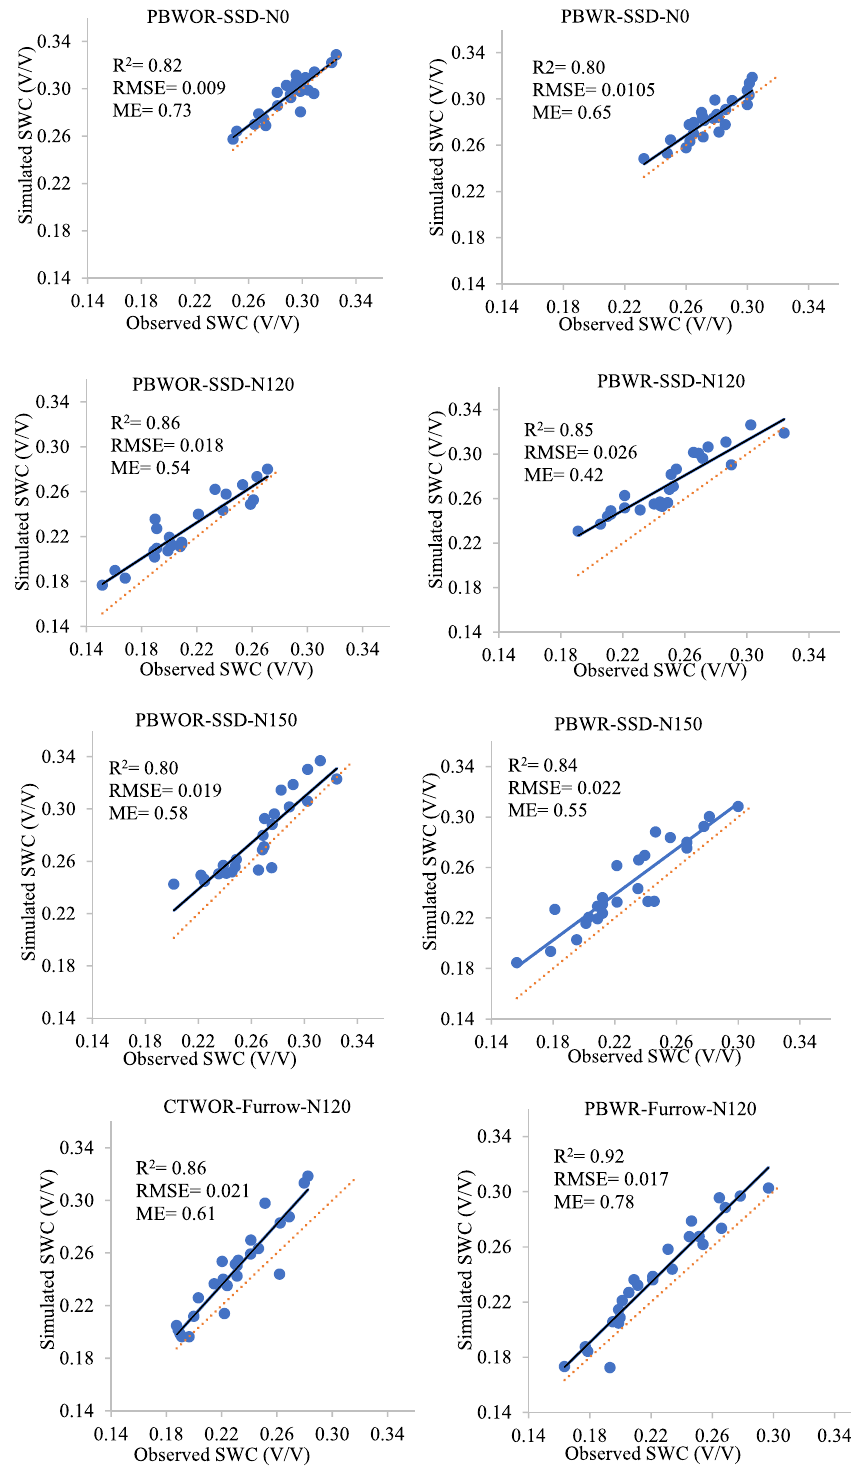
Figure 2. Observed and simulated soil water contents (SWCs) under different tillage, residue, N and irrigation management treatments. RMSE: Root Mean Square Error; ME: Model efficiency. For treatment detail please see Table 4. The continuous line is the relation between observed vs predicted and dotted line is 1:1